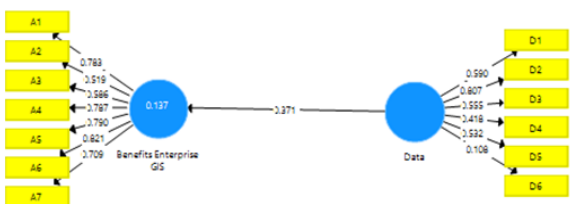
Figure 4. PLS SEM conceptual model for